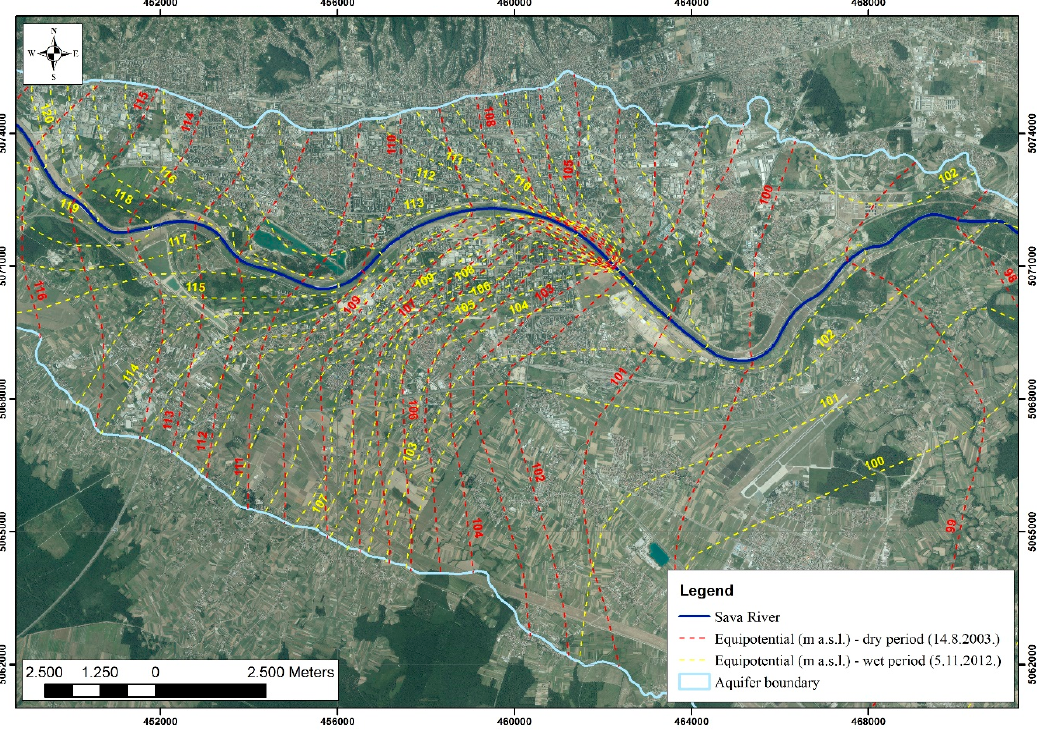
Table 1. Hydrogeological*, pedological, and water stable isotope data (average values of δ 18 O, δ 2 H, and d-excess) used in the analysis (*minimum and maximum water levels registered between 2000 and 2014). Observation Well